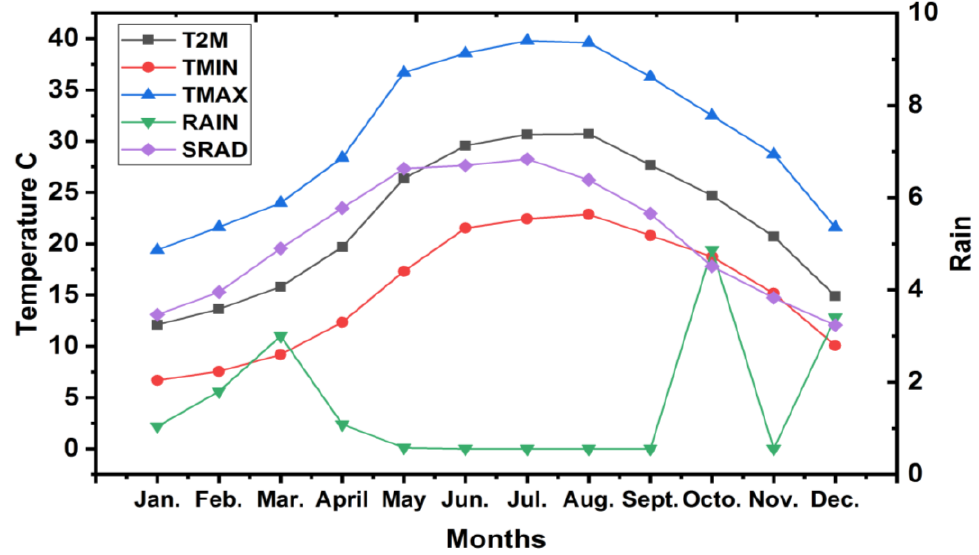
Figure 8. The average monthly temperature. (T2M): Temperature Average at 2 Meters (°C); (TMIN): Temperature at 2 Meters Minimum (°C); (TMAX) Temperature at 2 Meters Maximum (°C); (RAIN) Precipitation (mm); and (SRAD) Solar Radiation (MJ/m^2/day) during the growing season. Table 4. Physical and chemical properties of the experimental farm soil. Soil Physical Analysis Soil Chemical Analysis